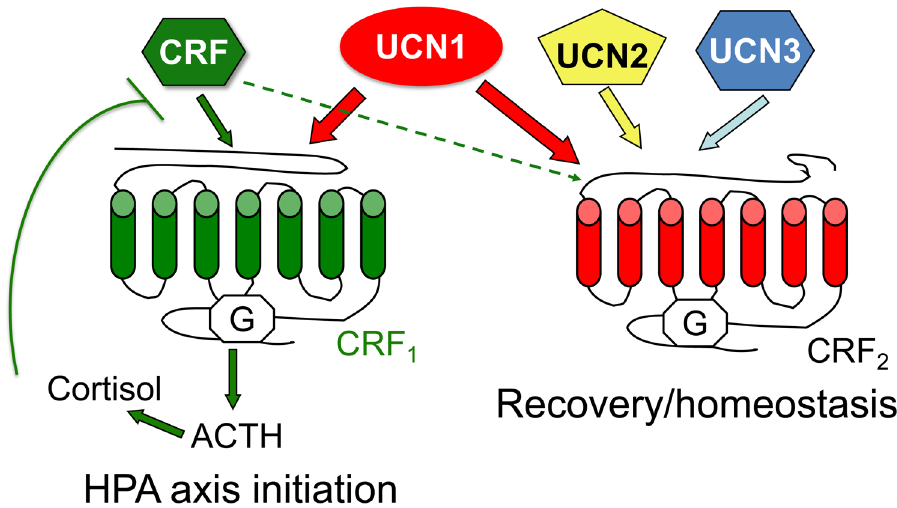
Figure 2. CRF family of peptide hormones and their two G protein-coupled receptors (GPCR) receptors, CRF 1 and CRF 1 . Based on in vitro binding assays, CRF binds mainly to CRF 1 , whereas urocortin 1 (UCN1) binds to both receptors, but with 10-fold higher affinity than other ligands. UCN2 and UCN3 bind exclusively to CRF 2 . The activation of CRF 1 receptors by CRF in the hypothalamus initiates the hypothalamic–pituitary–adrenal (HPA) axis, ultimately resulting in the release of glucocorticoids (cortisol in primates and corticosterone in rodents) from the adrenal cortex. Activation of CRF 2 by urocortins is key for recovery from stress responses and returning to homeostasis.